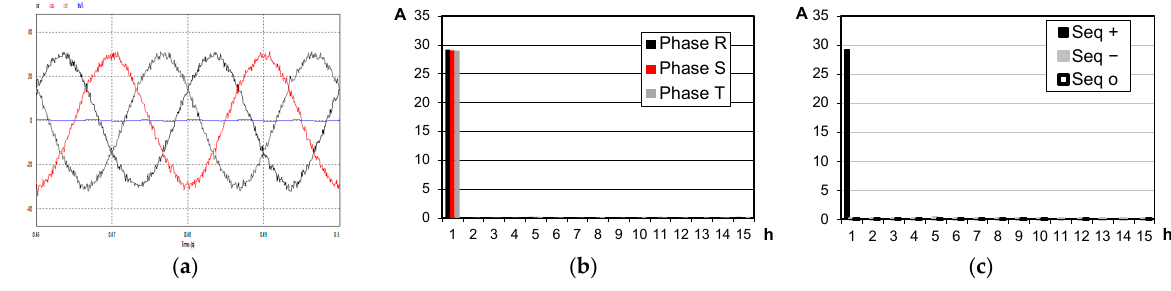
Figure 14. Case C—voltage and current in phase R . Figure 14. Case C - voltage and current in phase R .